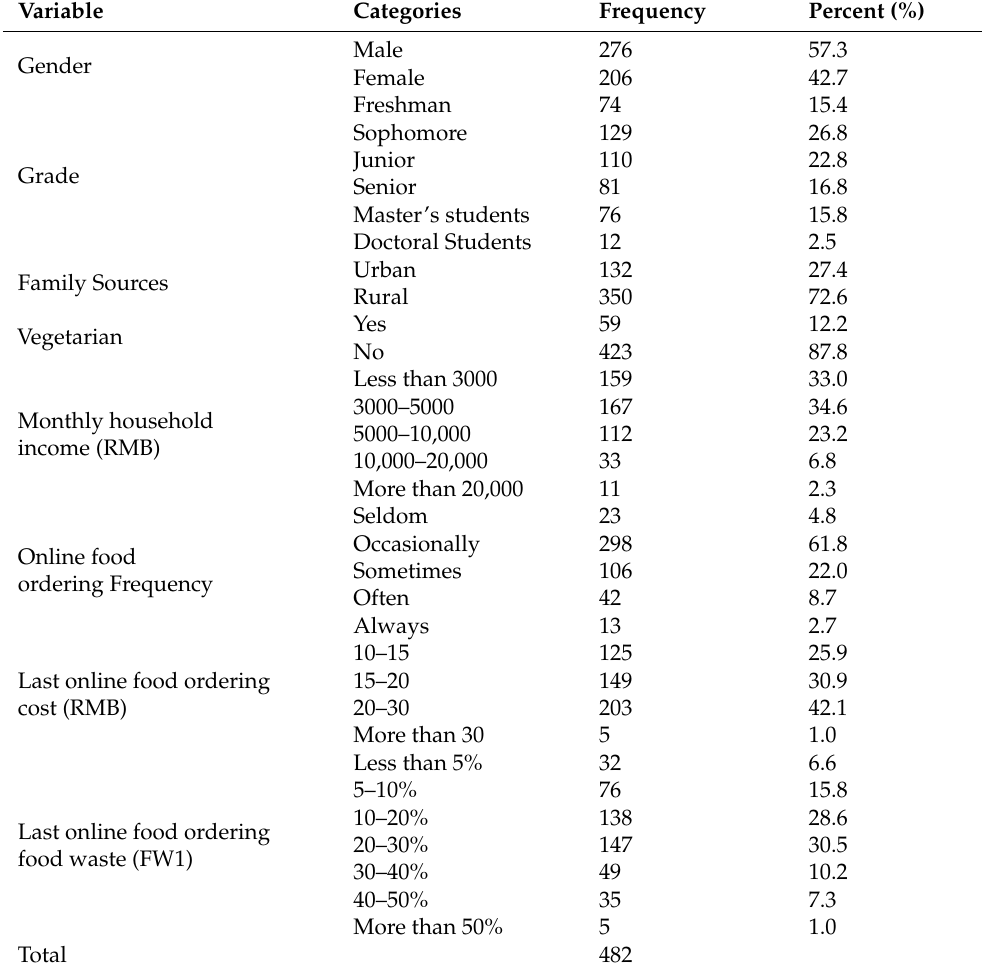
Table 1. Demographic information and background